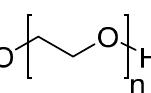
Figure 15. Polyethylene glycol (PEG) structure.